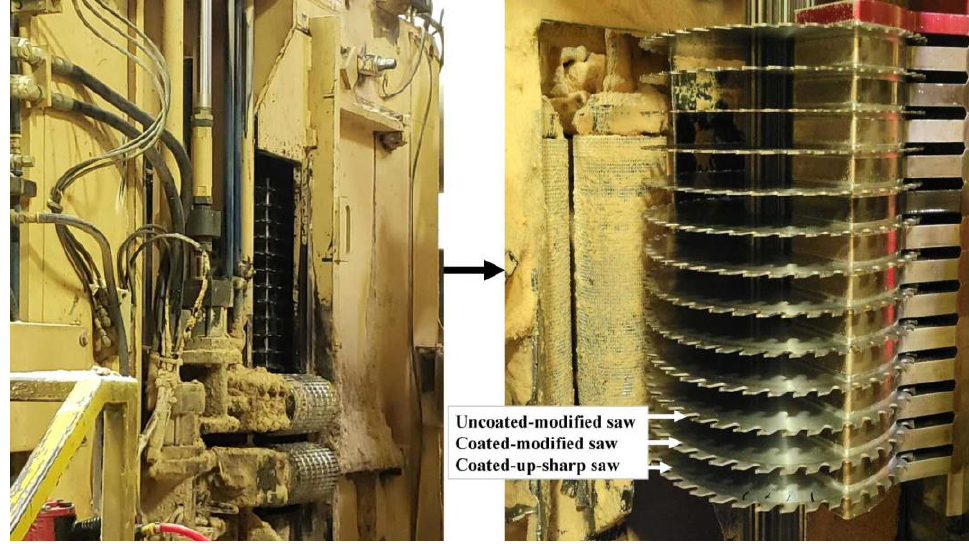
Figure 5. Image of the bull-edger system used in this study.